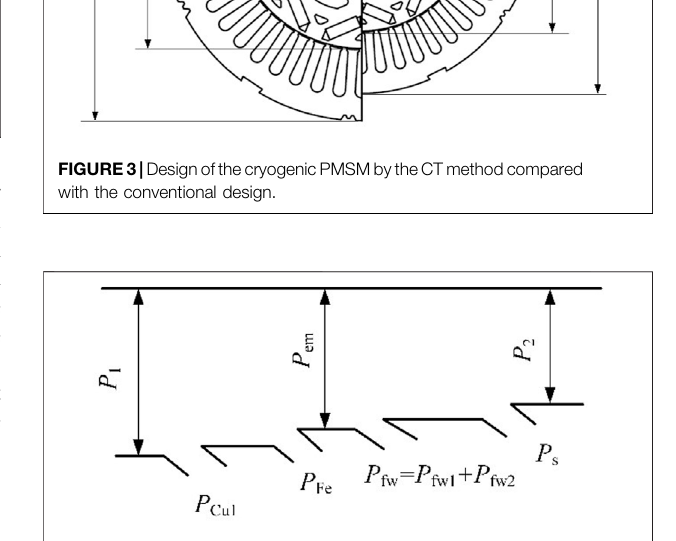
FIGURE 4 | Power procedure of the